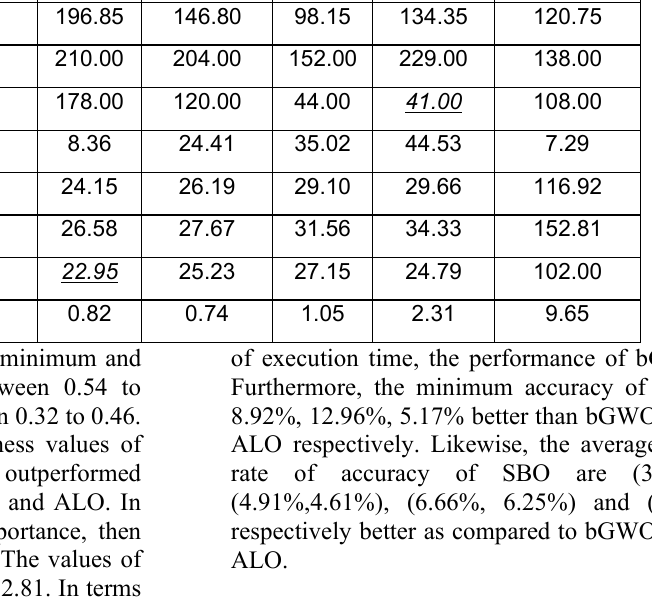
Table 5. Statistical Analysis of SBO and its chaotic